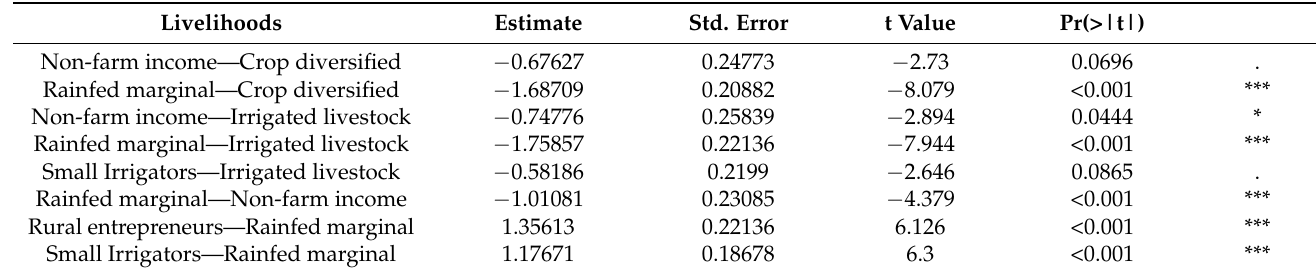
Table 5. Mean differences between livelihoods.